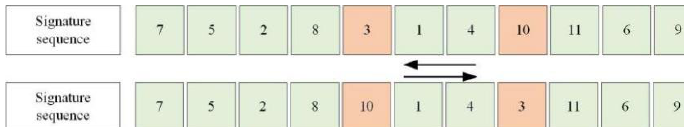
Figure 9. Switch operation, 1 V .